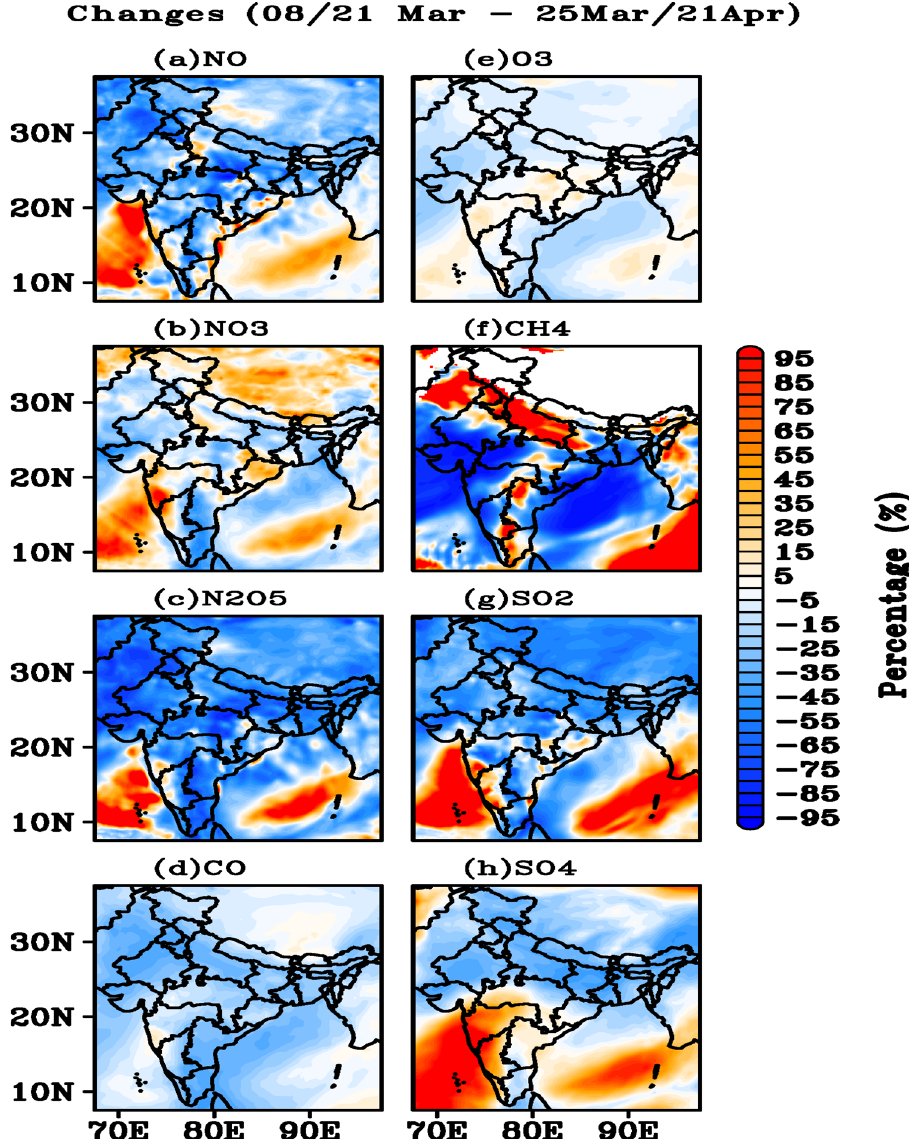
Figure 4. Percentage difference in the ( a ) NO, ( b ) NO 3 − , ( c ) N 2 O 5 , ( d ) CO, ( e ) O 3 , ( f ) CH 4 , ( g ) SO 2 , and ( h ) SO 42− observed between the PLD and DLD periods based on WRF-Chem simulations for India and adjacent regions. The figures are plotted using GrADS V2.2.1 software (http:// cola. gmu. edu/